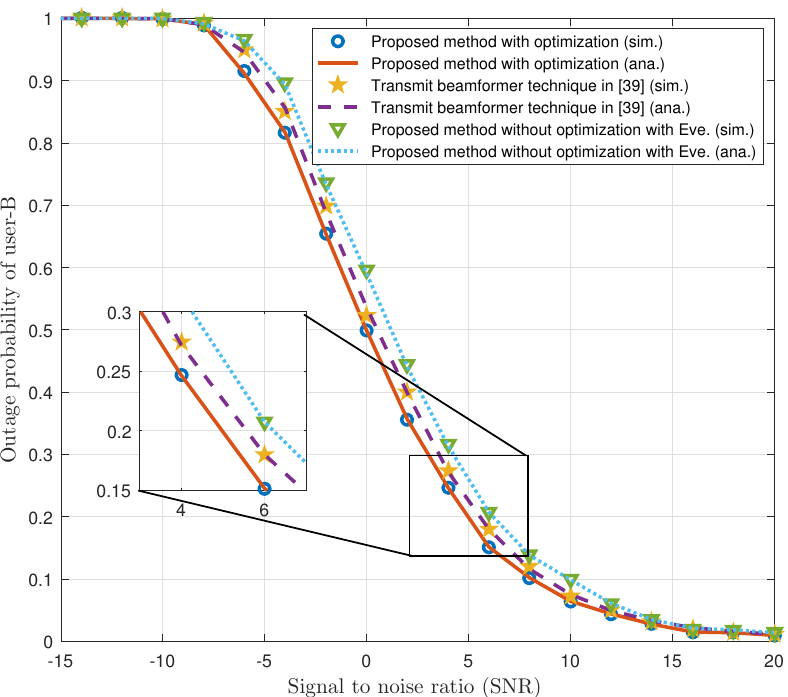
Figure 7. Impact of predefined threshold ( γ th ) at N = 7 on the outage probability of ( a ) user-B and ( b ) Eve.